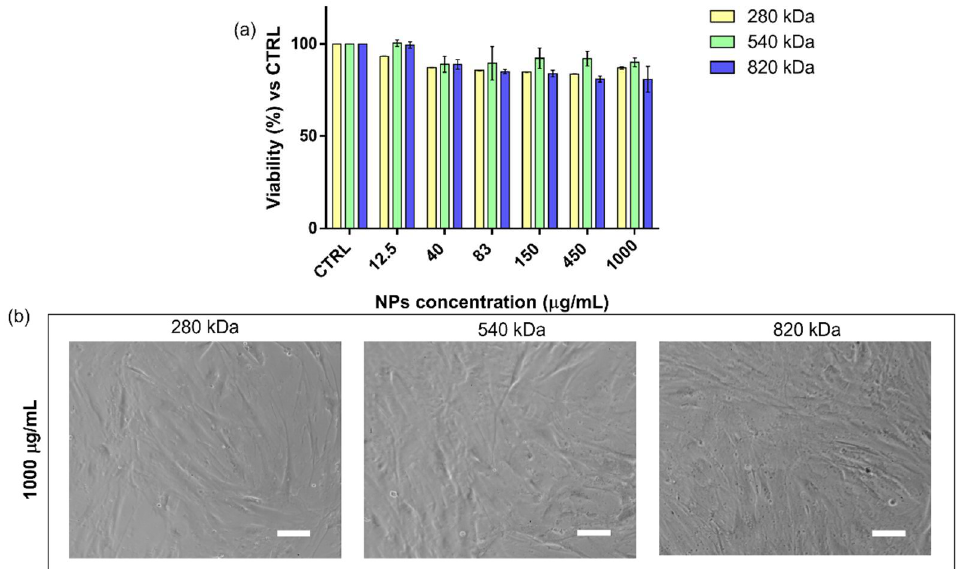
Figure 2. ( a ) Cytotoxicity results obtained by the incubation (24 h) of hMSCs with increasing concentration of HA/CS NPs (12.5–1000 µg/mL). Different HA Mws were used, 280 kDa (yellow bar), 540 kDa (green bar) and 820 kDa (blue bar). The graph represents the cell viability percentage compared with that of untreated cells (CTRL). ( b ) Optical microscope images of hMSCs treated for 24 h with 1000 µg/mL of HA/CS NPs (scale bar = 50 µm).